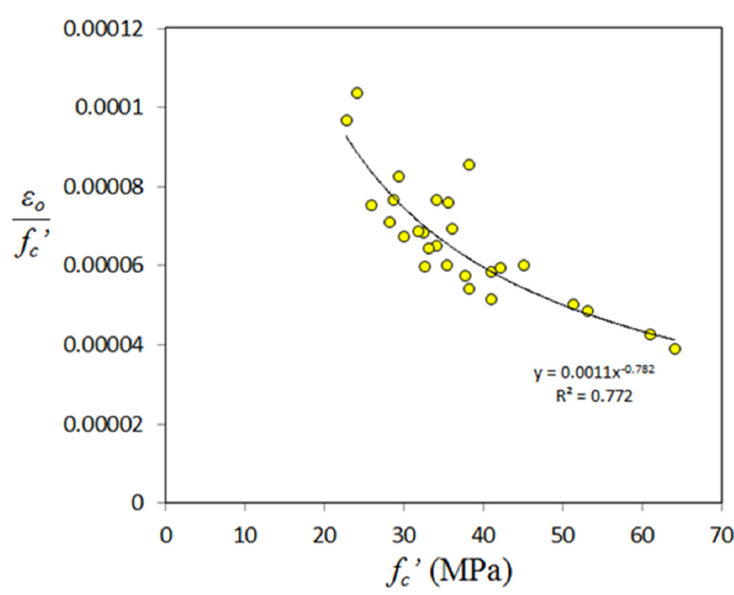
Figure 17. Variation of normalized ε o with compressive strength of GPC.